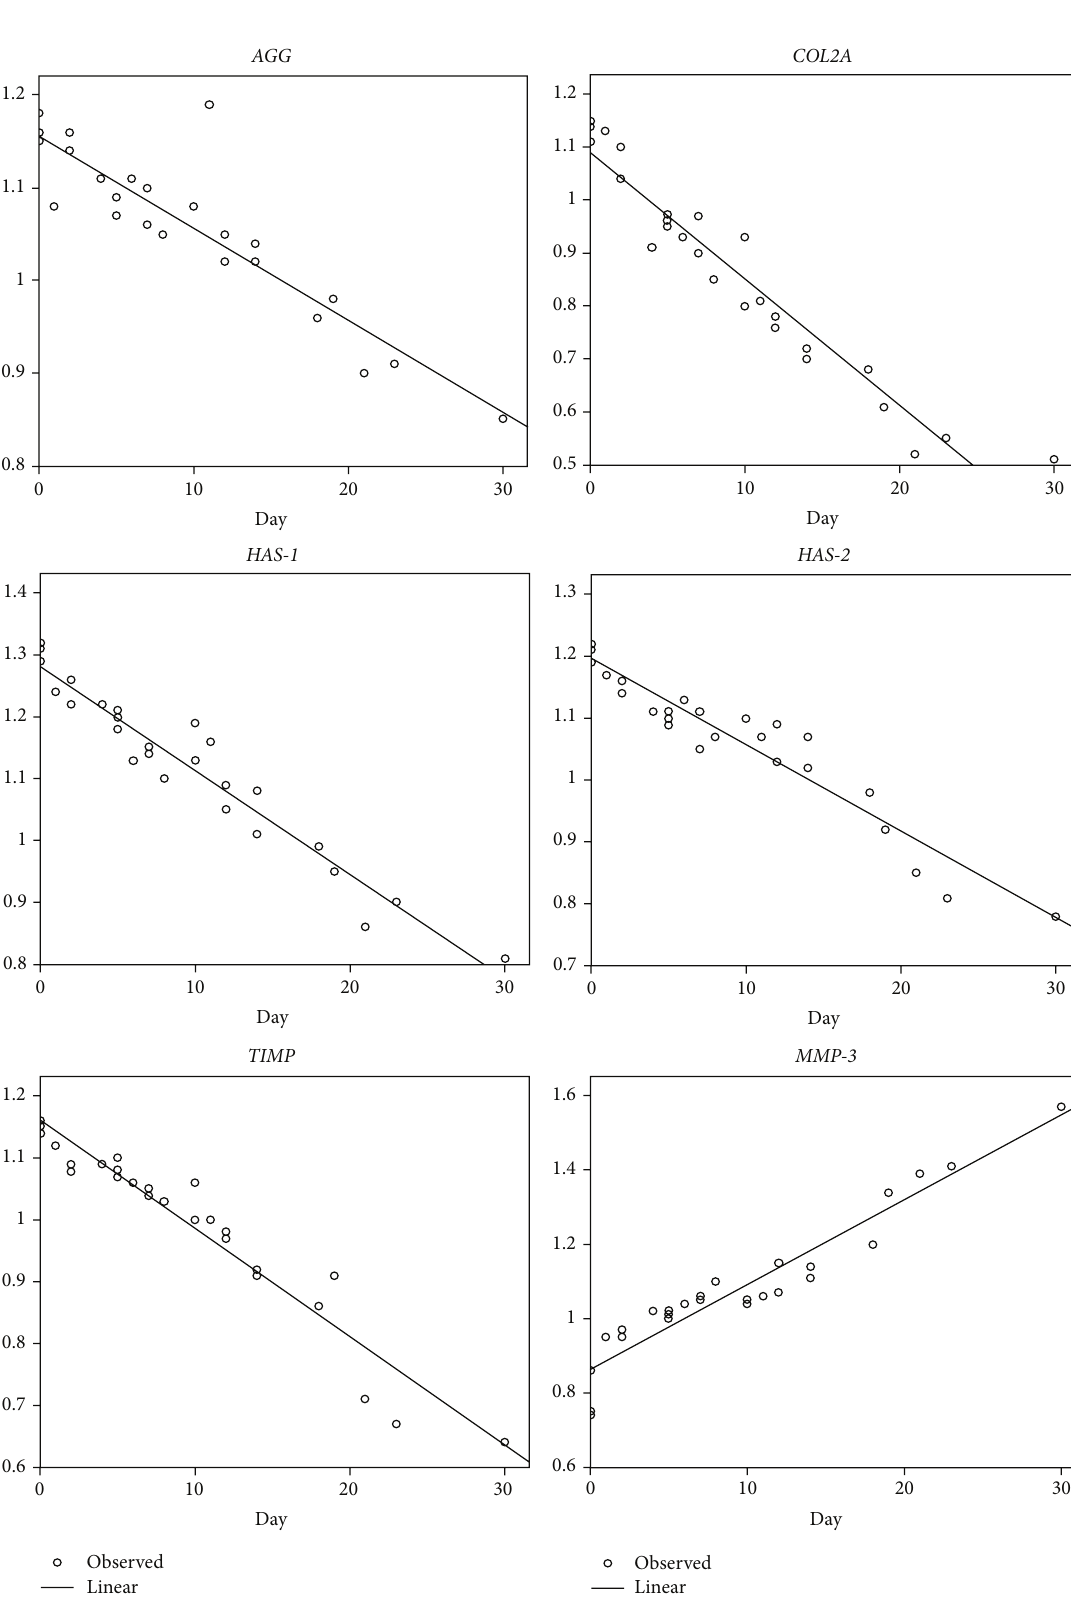
Figure 1: The relationship between relative expression of nonapoptotic genes and days of luxation ( AGG , aggrecan; COL2A , type II collagen (alpha-1 chain); HAS-1 , hyaluronan synthase-1; HAS-2 , hyaluronan synthase-2; TIMP , tissue inhibitor of metalloproteinase; MMP-3 , matrix